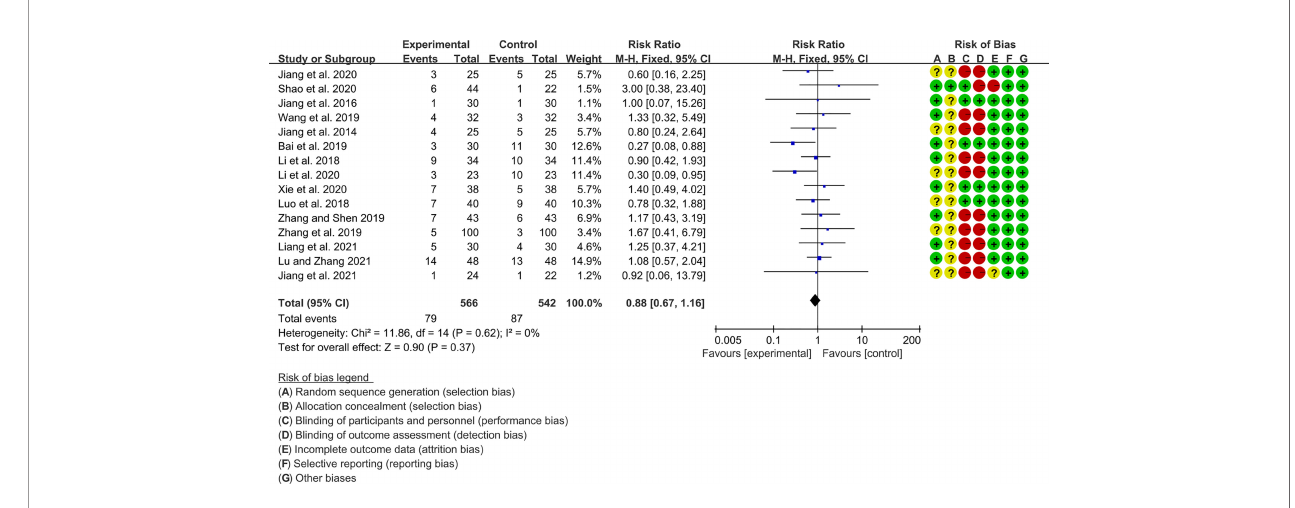
FIGURE 10 | Adverse